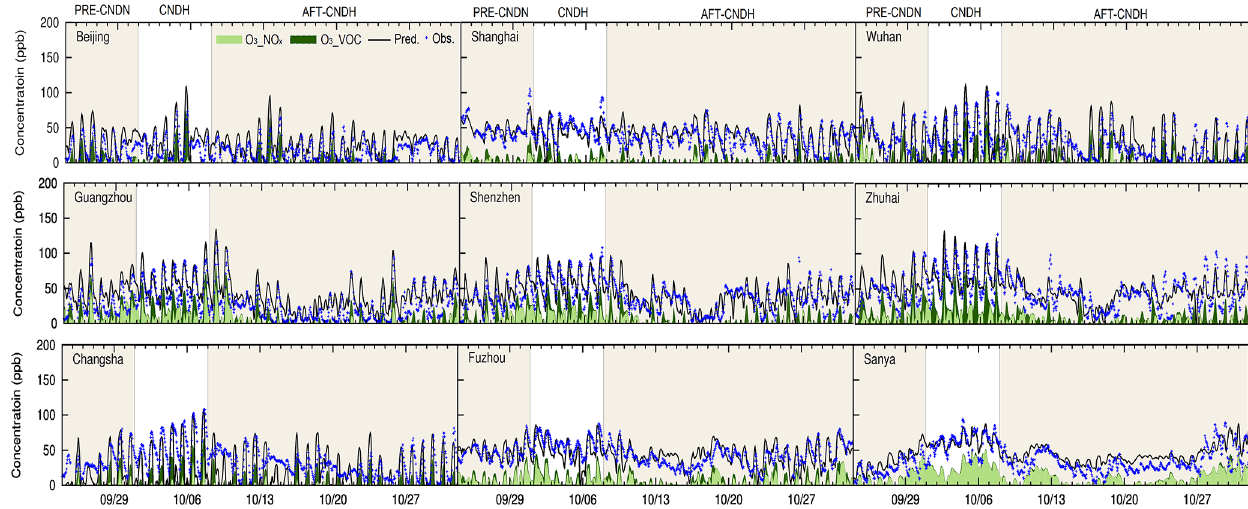
Figure 3. Hourly O 3 and its source apportionment results in nine key